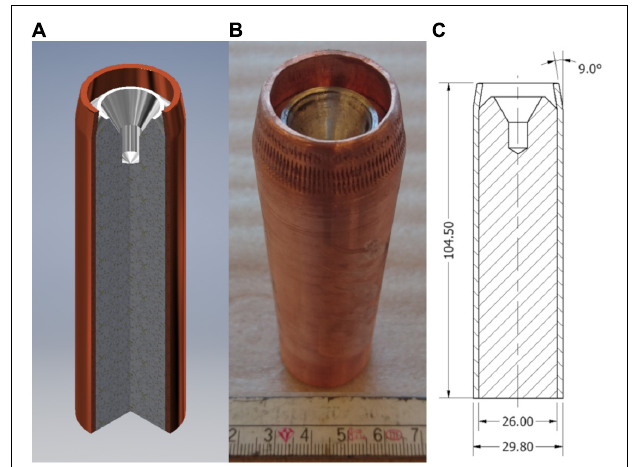
FIGURE 1 | (A) Digital 3D model, (B) photograph, and (C) drawing of the manufactured